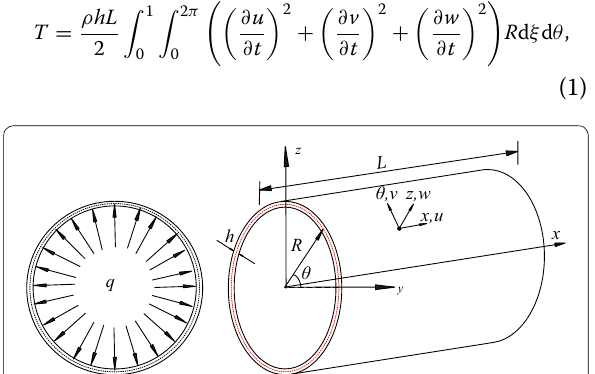
Figure 1 Cylindrical shell model of a pressure